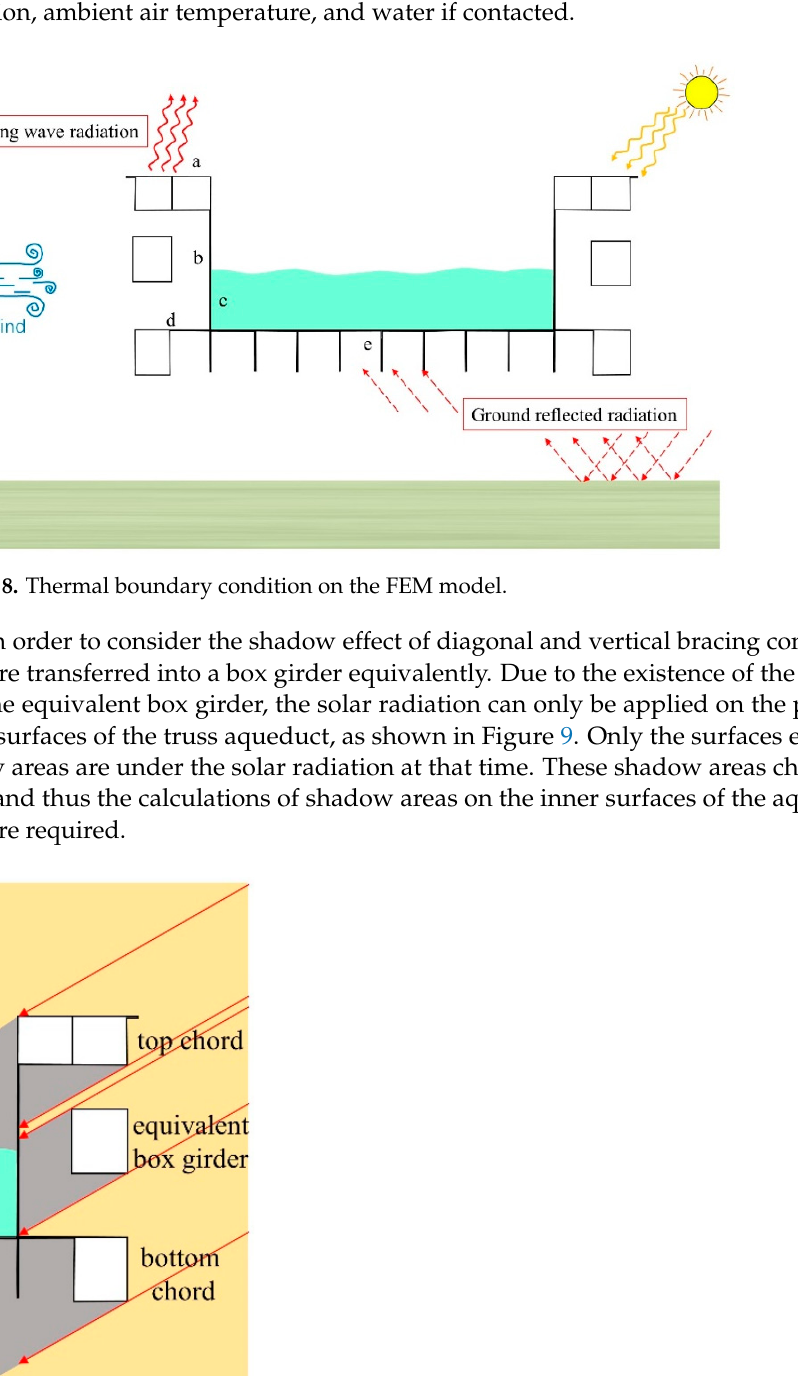
Figure 8. Thermal boundary condition on the FEM model.